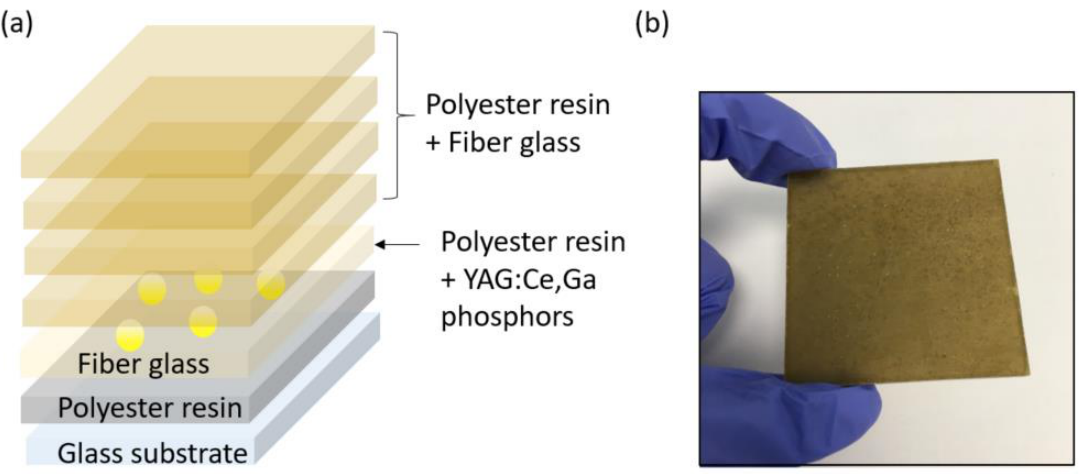
Figure 2. ( a ) Multilayer structure of the laminate composites. ( b ) Optical image of the laminate composites.